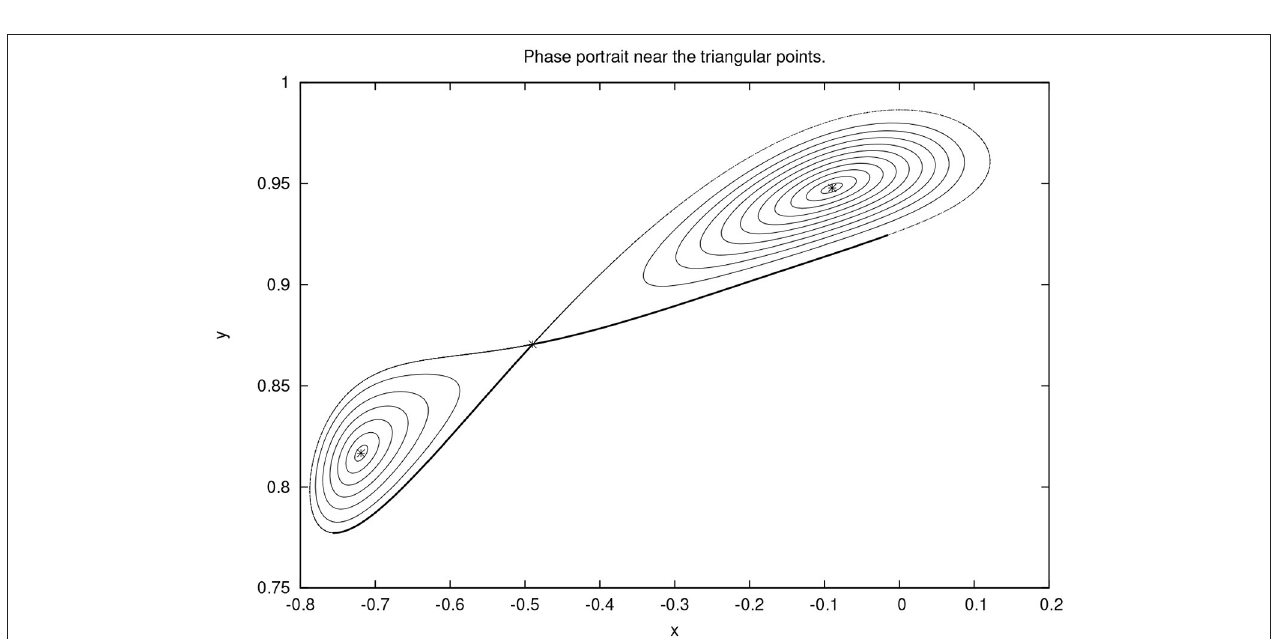
FIGURE 4 | Stroboscopic map near the triangular points: Horizontal axis x . Vertical axis y . See text for more details.